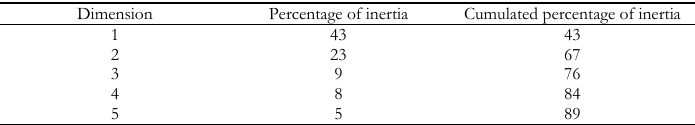
(Cumulated) percentage of inertia explained by the first five principal components Dimension Percentage of inertia Cumulated percentage of inertia 1 43 43 2 23 67 3 9 76 4 8 84 5